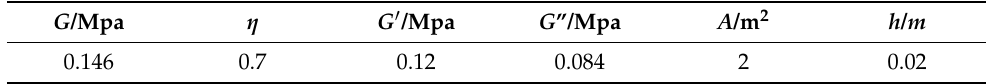
Table 5. Parameters of the viscoelastic material.